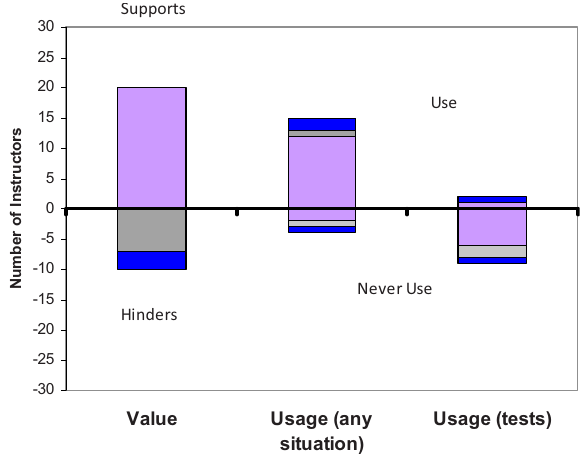
FIG. 6. (cid:1) Color (cid:2) Value and usage of features related to the teach- ing goal of motivating students. The legend is in Fig. 3.